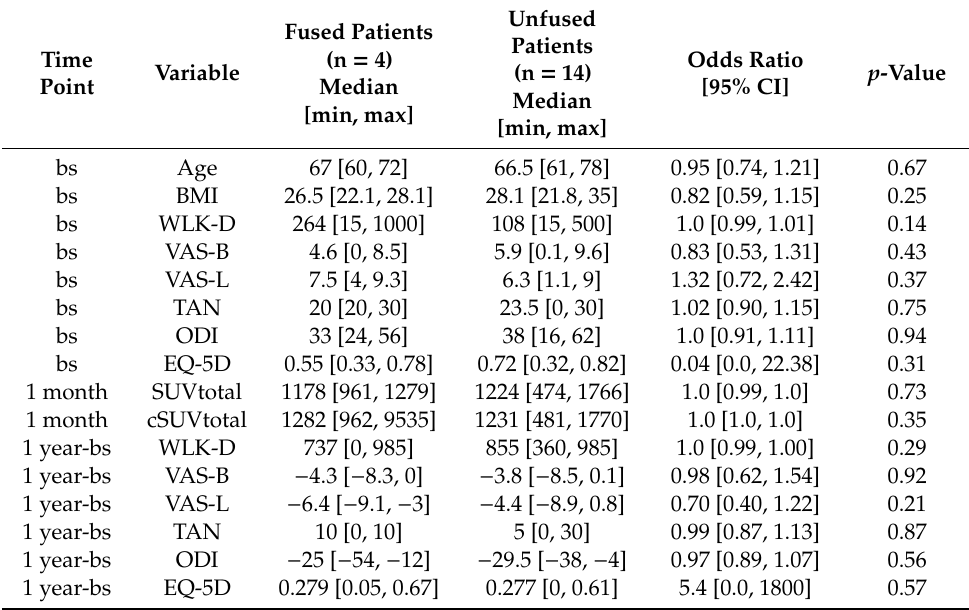
Table 1. Clinical and PET scores by timepoint and fusion